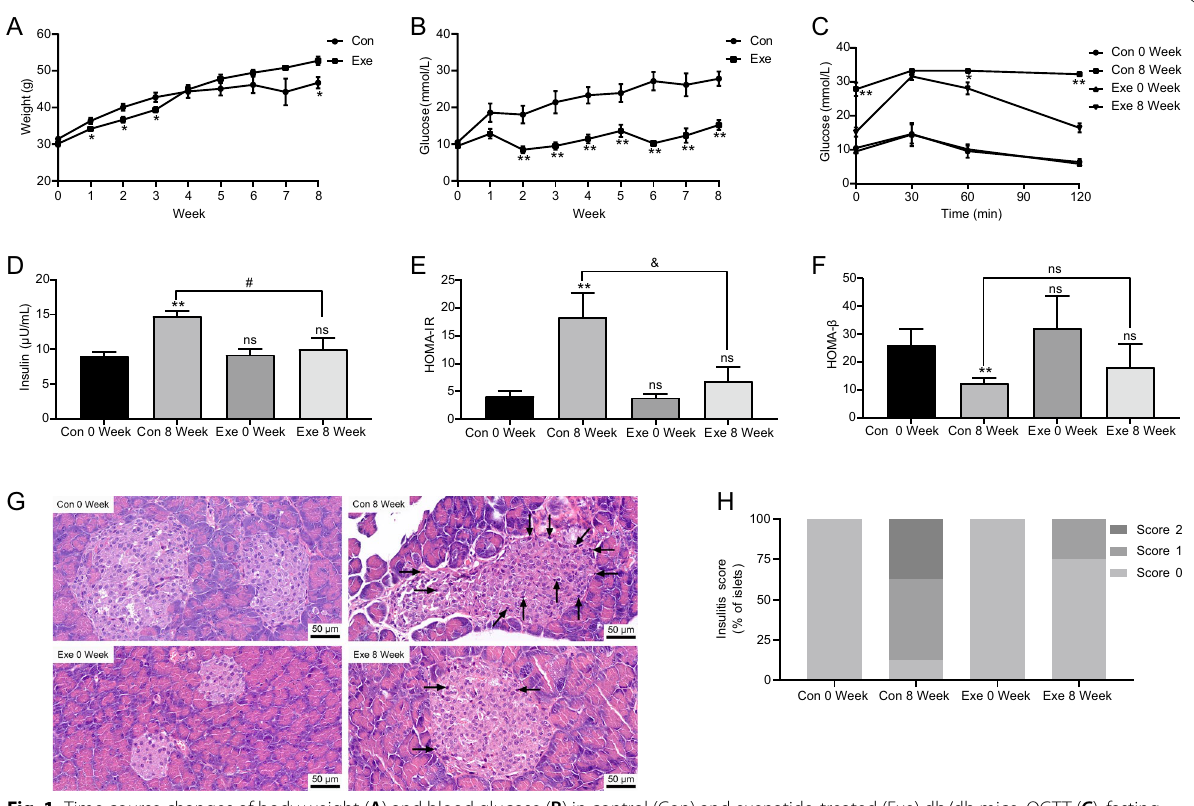
Fig. 1 Time course changes of body weight ( A ) and blood glucose ( B ) in control (Con) and exenatide-treated (Exe) db/db mice. OGTT ( C ), fasting insulin ( D ), HOMA-IR ( E ), HOMA-β ( F ), representative HE micrographs of pancreatic insulitis ( G ), and the percentage of insulitis scores of pancreatic islets ( H ) in Con and Exe group before and after 8-week treatment. Data are presented as mean control ( A , B ), control 8 week ( C ), or control 0 week ( D – F ); & P < 0.01, # P < 0.05 vs control 8 week ( D – F ); ns P > 0.05. Scale bar indicates infiltrated cells. OGTT oral glucose tolerance test, HOMA-IR homeostasis model assessment of insulin resistance, HOMA-β homeostatic model assessment of β cell